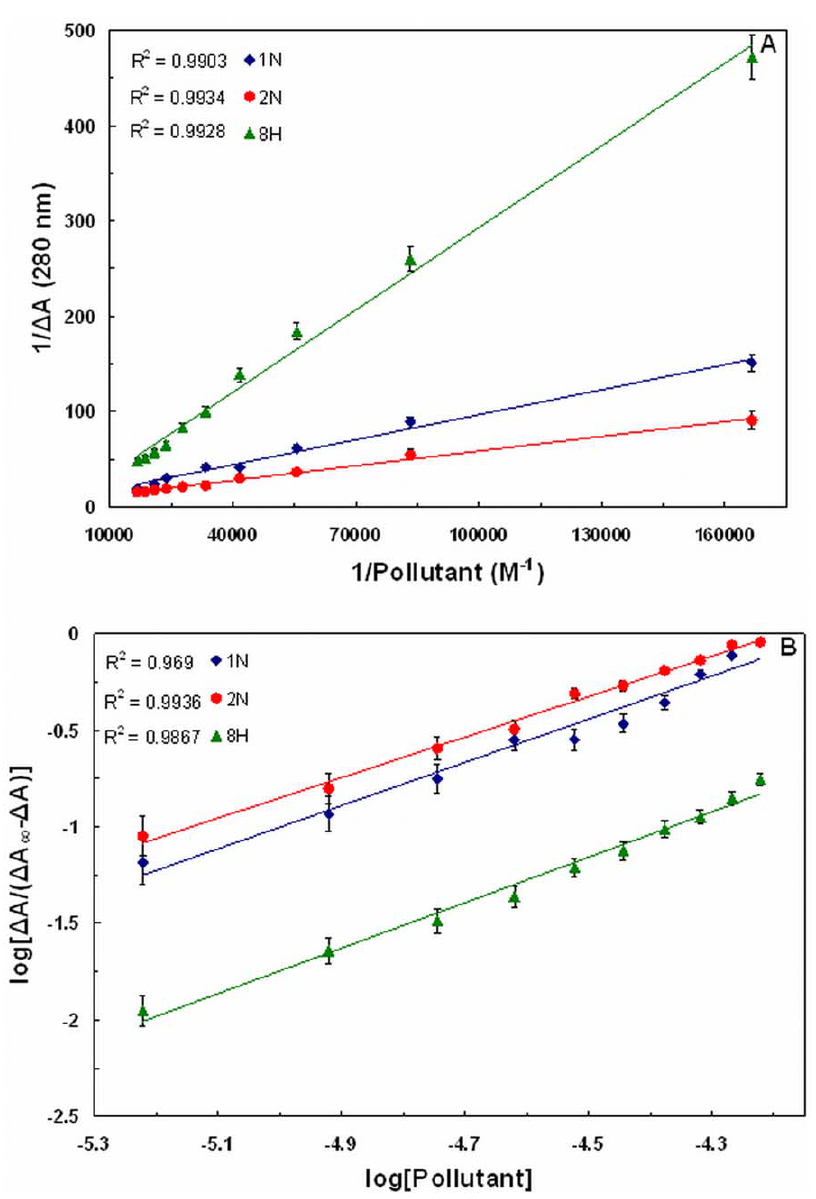
Figure 2. (A) Plot of 1/ D A (at 280 nm) against 1/[S] and (B) Hill plot of log [ D A/( D A ‘ - D A)] vs log [Pollutant] at 37 6 C. HSA=12 m M and1N=2N=8H=0 to 60 m M. doi:10.1371/journal.pone.0026186.g002 phenolic compounds were performed with Autodock4.0 program [12]. Autodock uses Lamarkian genetic algorithm to calculate the possible conformations of the ligand that binds to the protein. Gasteiger charges were added to the ligands. Polar hydrogen atoms, Kollman charges were merged to the protein. A Grid of 60 6 60 6 60 A˚ with spacing of 0.375 A˚ was generated, covering all the active site residues. For docking simulations the parameters were set to 10 GA runs terminating after a maximum of 25, 00,000 energy evaluations, population size was set to150 and crossover rate of 0.8. For flexible docking, the above parameters were same, but the residues involve in rigid docking as well as some other important neighboring residues of binding sites were set to flexible. For further analysis, the conformer with the lowest binding energy with best fitness score was used. The binding